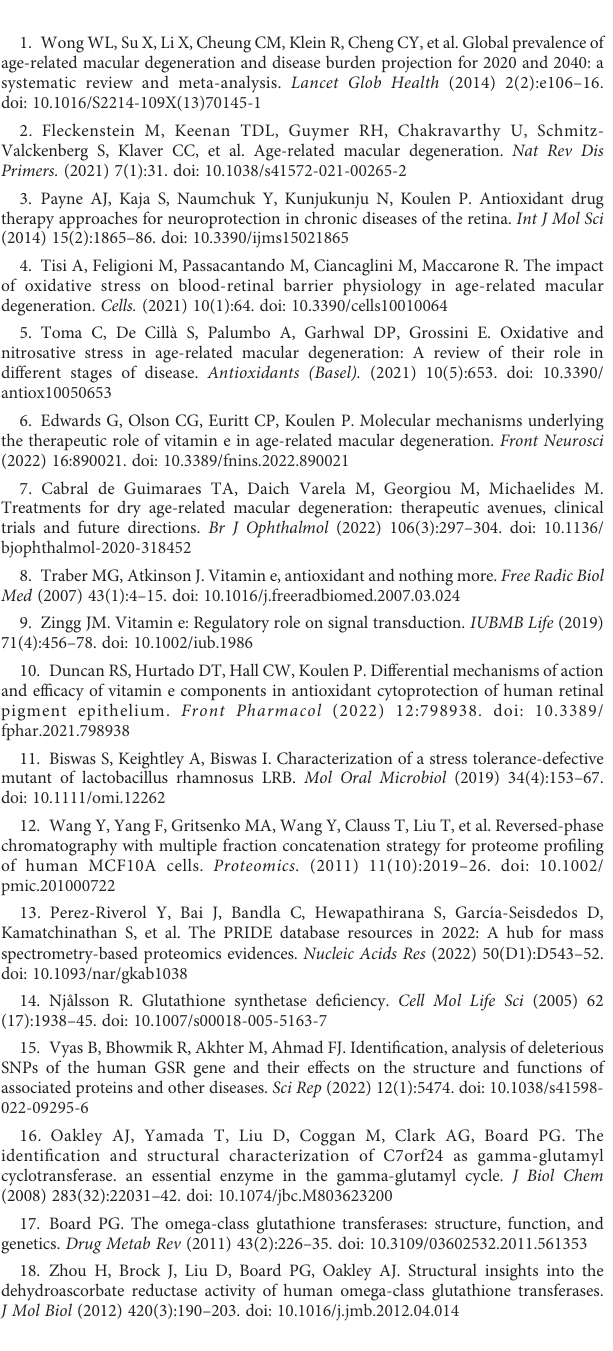
media containing either tBHP or vehicle control was added. Cells remained exposed to tBHP (or vehicle) for 24 hours. SUPPLEMENTARY FIGURE 2 Comparison of reactive oxygen species (ROS) measurement between tBHP and tocopherols in hTERT-RPE cells. hTERT-RPE cells were loaded with DCFDA, a redox-sensitive fl uorescent dye, for 1 hour, rinsed 3 times with PBS and exposed to either 100 m M tBHP or 100 m M a T or g T for 4 hours. Cells werereadin a plate readerto detect fl uorescence intensity. Exposure to tBHP led to a 5.8-fold increase in DCFDA fl uorescence indicating an elevated presence of ROS while exposure to tocopherols had no effect on DCFDA fl